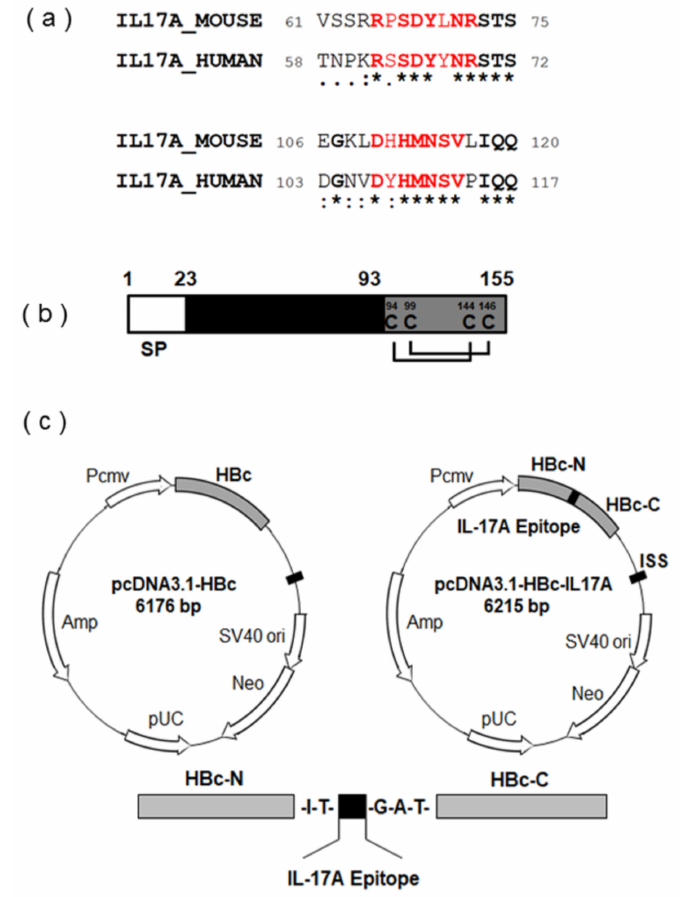
Figure 1. Plasmid DNA construction for IL-17A vaccination; ( a ) BLAST alignment for mouse and human IL-17A of two selected B cell epitope sequences, 17A1 (upper) and 17A2 (lower), compared based on sequence alignment using GENETYX (Software Development, Tokyo, Japan) and homology analysis using BLAST programs from the GenBank database. Epitope sequences of the IL-17A DNA construct are shown in red. Bold letters with asterisk (*) indicate regions where the two species have an identical amino acid; period (.) indicates weak similarity and colon (:) indicates strong similarity, while regions with conserved changes are indicated by no signature. Amino acid (aa) sequences are included with the numbers that represent the aa positions of each peptide. ( b ) Scheme of mouse IL-17A protein. Signal peptide (SP; aa 1–23), mature protein (aa 23–93), and two disulfide bonds (cysteine; aa 94–144 and 99–146) are indicated. ( c ) Construction of IL-17A DNA vaccines. Left panel: Plasmid map of pcDNA3.1-HBc. HBc gene was cloned downstream of CMV promoter. Right panel: Plasmid map of pcDNA3.1-HBc-IL-17A. DNA fragment encoding IL-17A epitope (17A1, 17A2) and its N- and C-terminal linkers were inserted at positions corresponding to amino acids 80–81 of hepatitis B core (HBc). Lower panel: Schematic representations of fusion protein HBc-IL-17A epitope construction. Oligonucleotide sequences of a dipeptide spacer, Ile-Thr, or a tripeptide spacer, Gly-Ala-Thr, were introduced at the N- or C-terminus of the IL-17A epitope, respectively. Coding region for the IL-17A epitope (17A1, 17A2) was inserted into the immunodominant region (aa 80–81) of HBc. Cloned IL-17A epitope sequences were designed to allow for conformational flexibility of spacers when the surface is exposed on the HBc particle. Spacers are represented by single letter